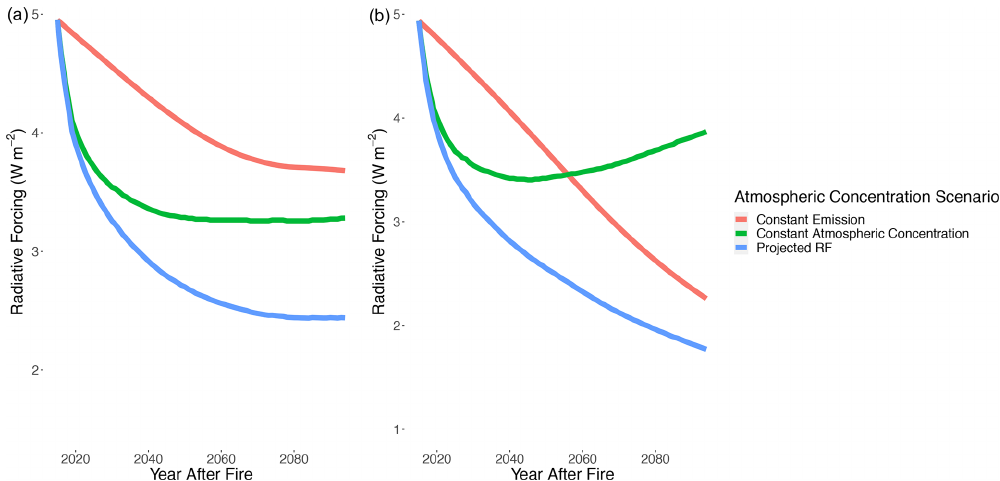
Figure A10. The radiative forcing of CO 2 emitted from the 2015 YKD fire season for RCP 4.5 (a) and 8.5 (b) when (i) holding the emission constant (red lines) so that no emitted CO 2 is sequestered; (ii) holding the background atmospheric concentration constant (green lines); and (iii) the combination of these, resulting in our main CO 2 radiative forcing equation (blue lines; Eq. 7). In the case of (i) (red lines), increasing atmospheric CO 2 concentrations dampen the radiative impact of fire-emitted CO 2 . In the case of (ii) (green lines), the only time-varying impact on CO 2 radiative forcing is ocean and land sinks, which become less effective and even reverse with more extreme climate change according to model results presented in Joos et al. (2013). These lines are similar to the impulse response function of CO 2 for their respective scenarios in Joos et al.